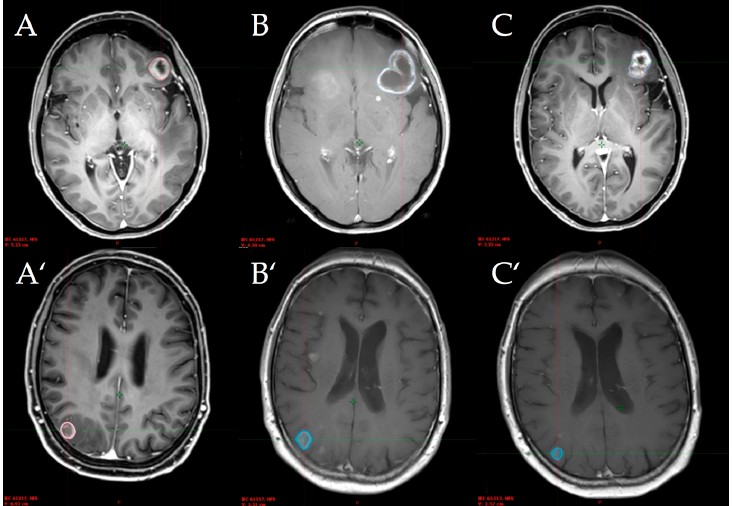
Figure 1. Lesion 1 of simultaneously treated patient No. 1 (top) and lesion 2 of simultaneously treated patient No. 4 (bottom) at baseline ( A ), first follow-up ( B ), and second follow-up ( C ) after stereotactic radiosurgery.